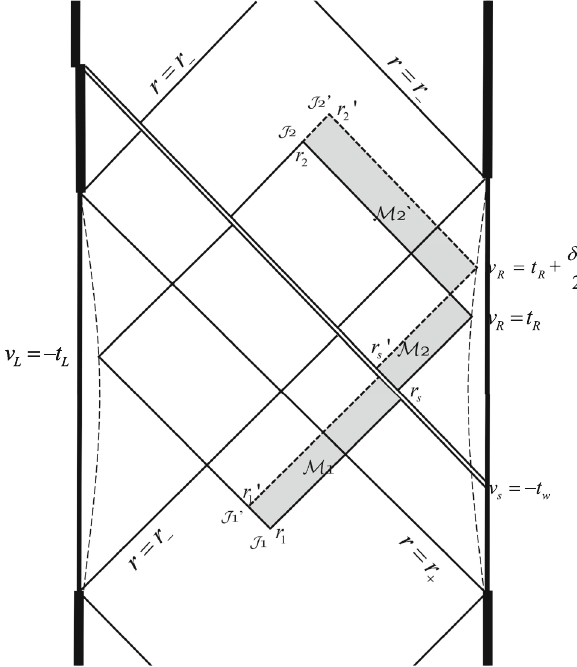
Fig. 1 The change of the Wheeler–DeWitt patches in a charged Vaidya-AdS black hole, where we fix the left boundary time t L and vary t R in the right